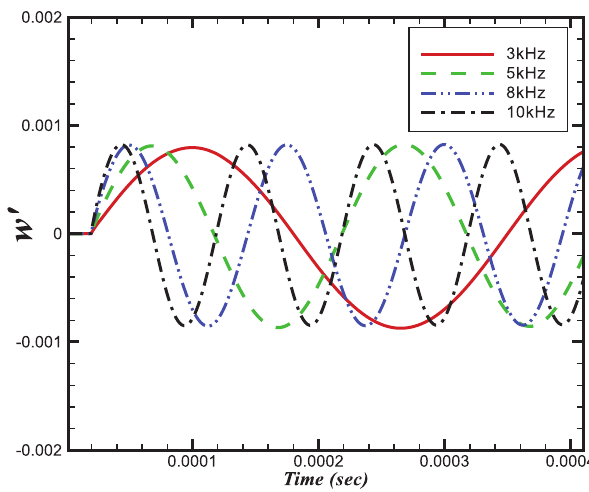
Figure 14. Relative change in the burning velocities at different frequencies and a constant amplitude of 100 Pa.